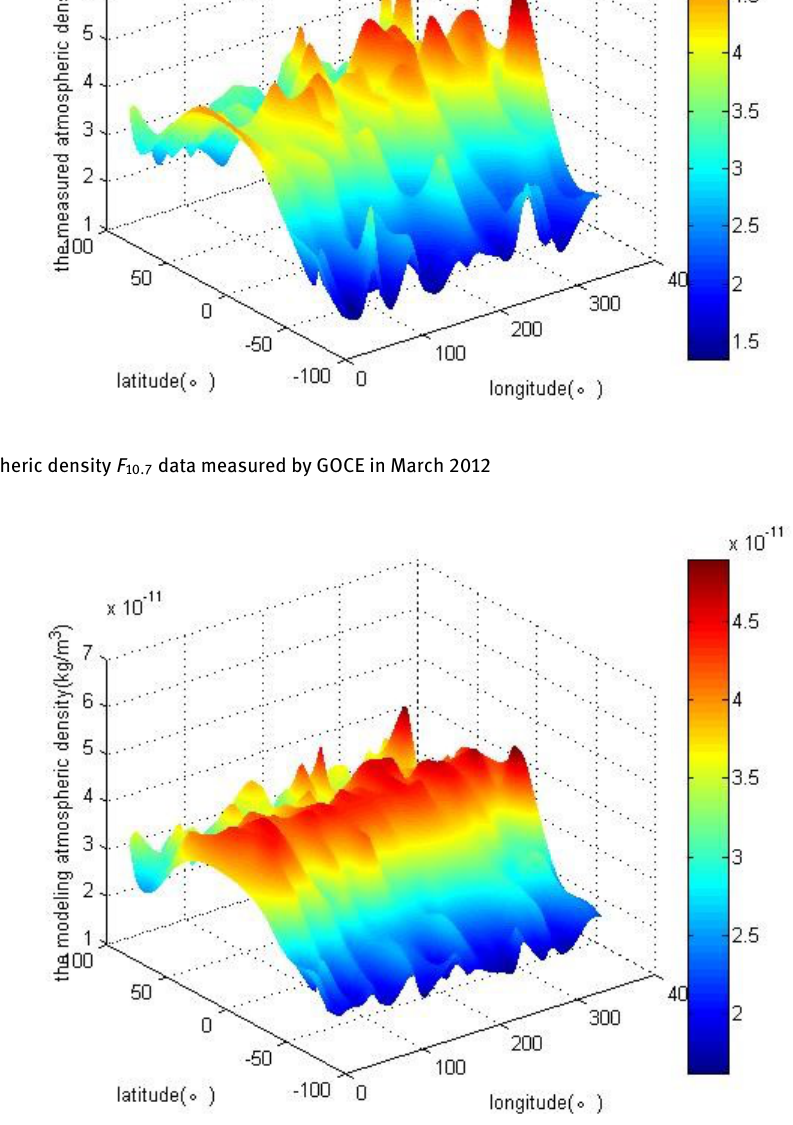
models show a certain consistency, and the two neural net- works atmospheric models also show a certain